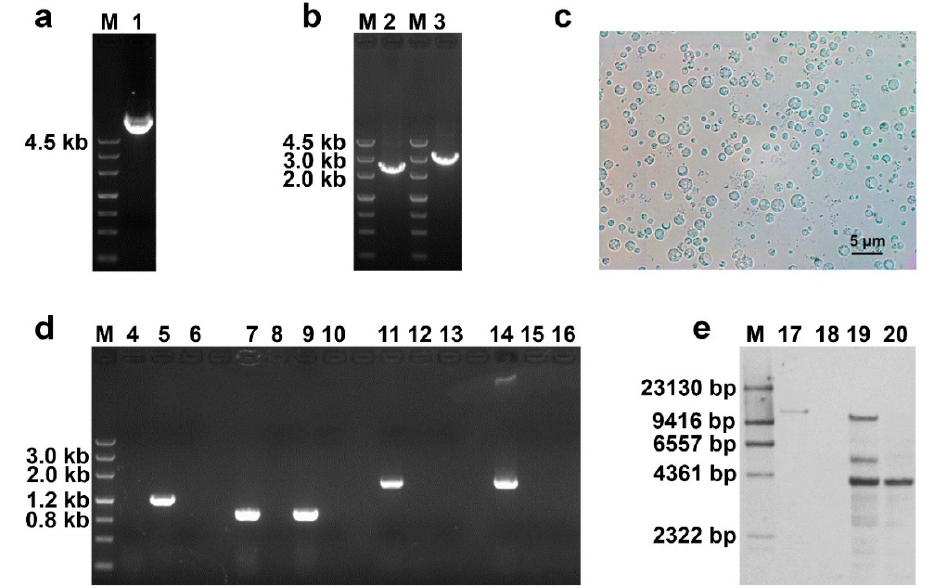
Figure 1. Knockout of the Cmfhp gene. ( a ) Extraction of the plasmid pCAMBIA0390-Bar-KOfhp (M: Figure1. Knockoutofthe Cmfhp gene. ( a